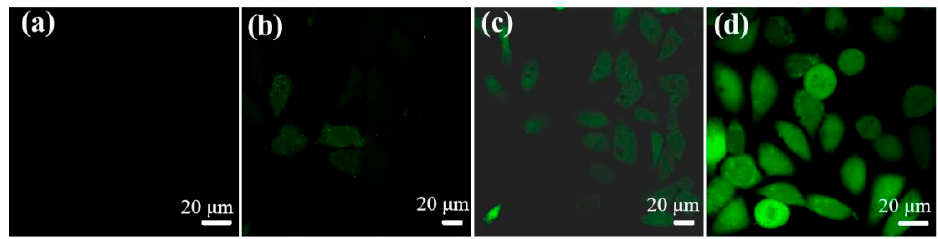
Figure 8. Reactive oxygen species (ROS) analysis of HepG2 cells incubated with Au@MPA-PEG-HA-ADH-Dox for 6 h by confocal microscopy. ( a ) Control; ( b ) 20 μ g/mL; ( c ) 50 μ g/mL; ( d ) 100 μ g/mL.